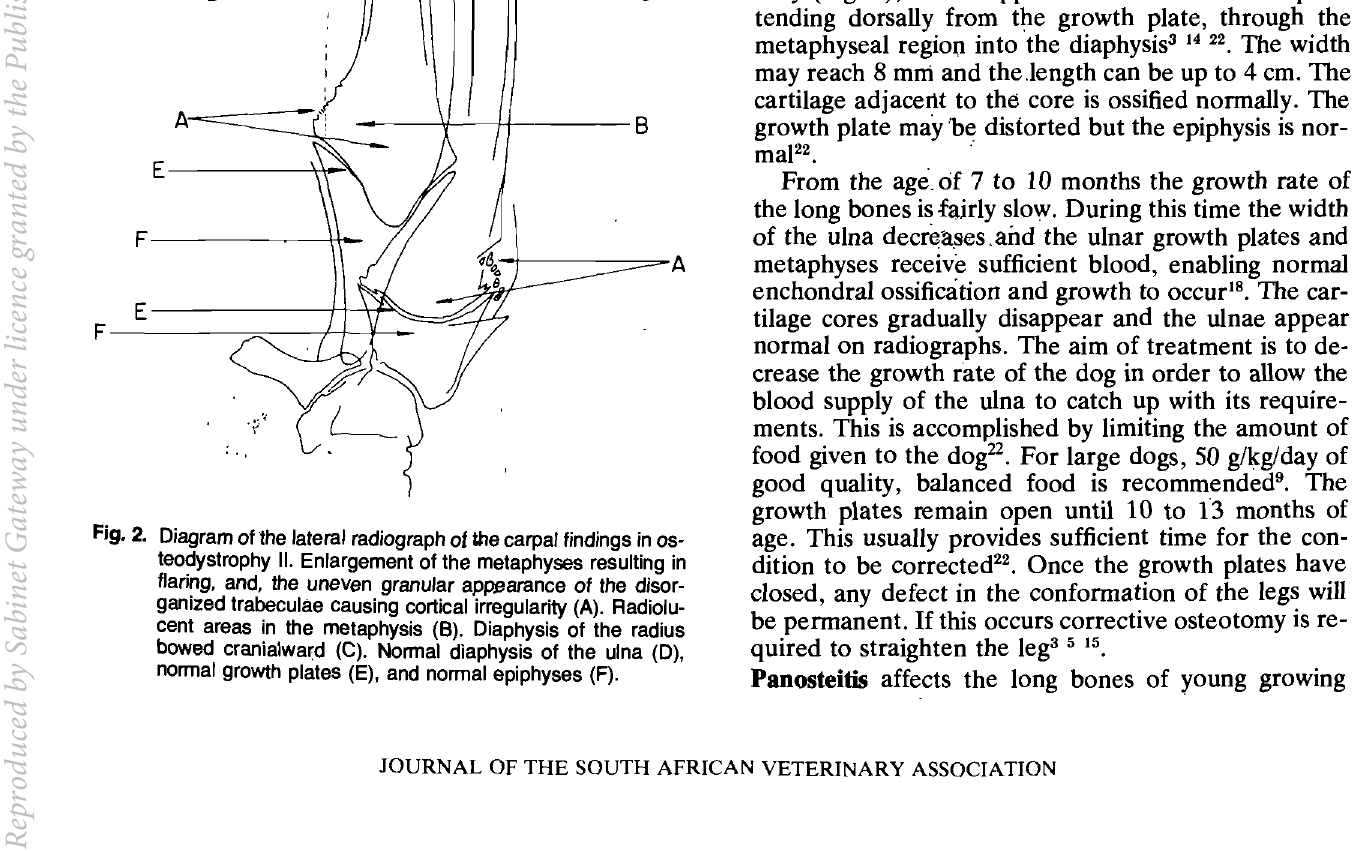
Fig. 2. Diagram of the lateral radiograph ot the carpal findings in os teodystrophy II. Enlargement of the metaphyses resulting in flaring, and, the uneven granular appsarance of the disor ganized trabeculae causing cortical irregularity (A). Radiolu cent areas in the metaphysis (8). Diaphysis of the radius bowed cranialwa~d (C). Normal diaphysis of the ulna (D), normal growth plates (E), and normal epiphyses